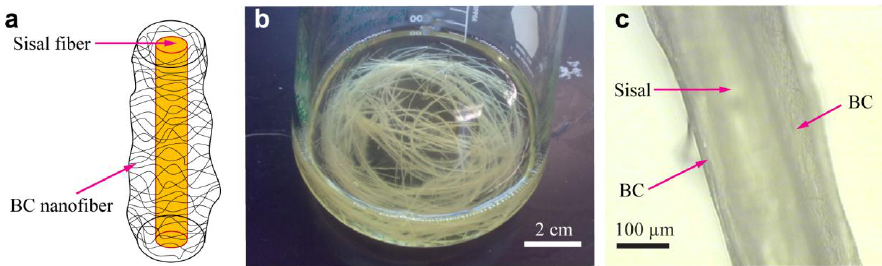
Figure 3. BC-sisal hybrid fibrous structure. Schematic of the BC-sisal hybrid ( a ), a photograph of BC-sisal hybrid fibers in the culture medium ( b ) and an optical image showing a single BC-sisal hybrid fiber ( c